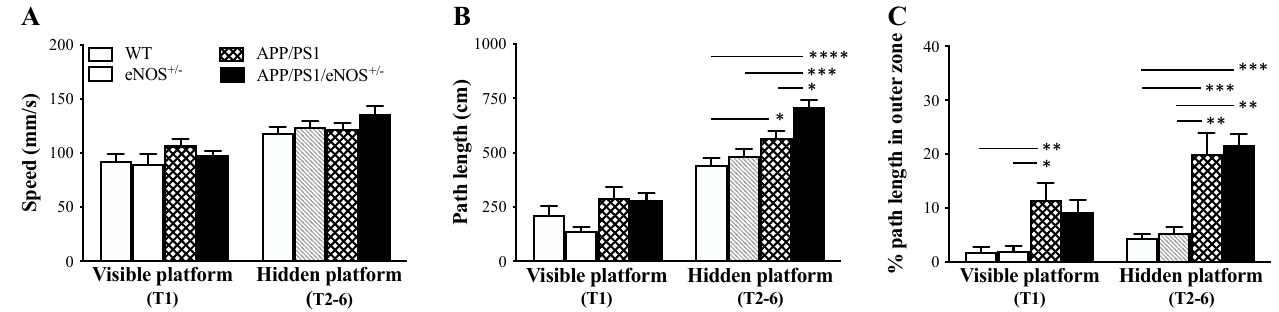
Figure 3. Mean (± SEM) speed ( A ), path length to reach the platform ( B ) and percentage of path length in the outer zone (thigmotaxic swimming; ( C ) during trial one (T1; visible platform) and trials two–six (T2–6; hidden platform) in 8-months old wildtype (WT), eNOS +/ − , APP/PS1 and APP/PS1/eNOS +/ − mice ( n = 8–12/genotype). * indicates a significant difference between groups at * p < 0.05, ** p < 0.01, *** p < 0.001 or **** p < 0.0001.